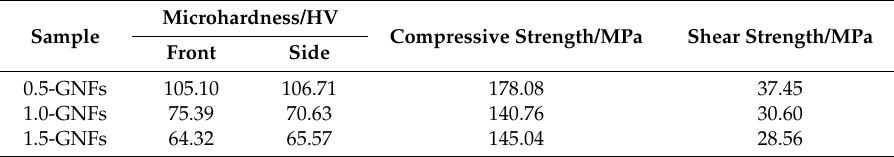
Table 2. Mechanical properties of the nanocomposites sintered at 1000 ◦